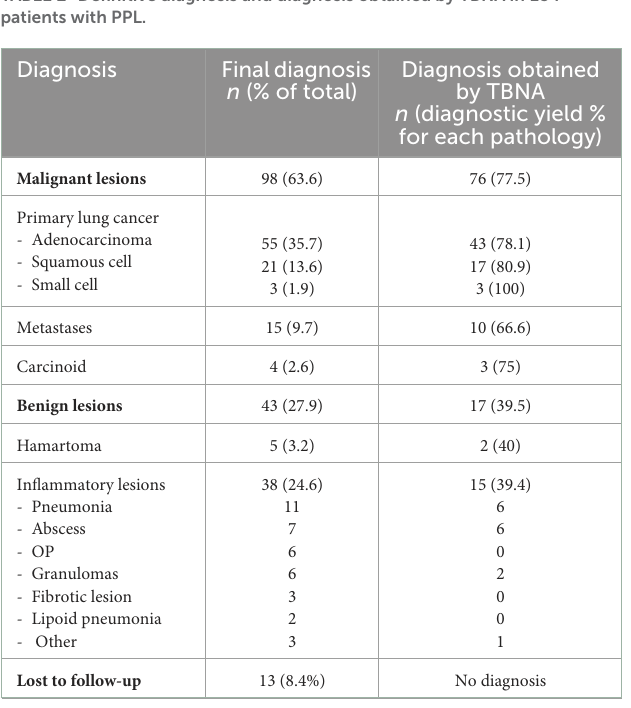
TABLE 2 Definitive diagnosis and diagnosis obtained by TBNA in 154 patients with